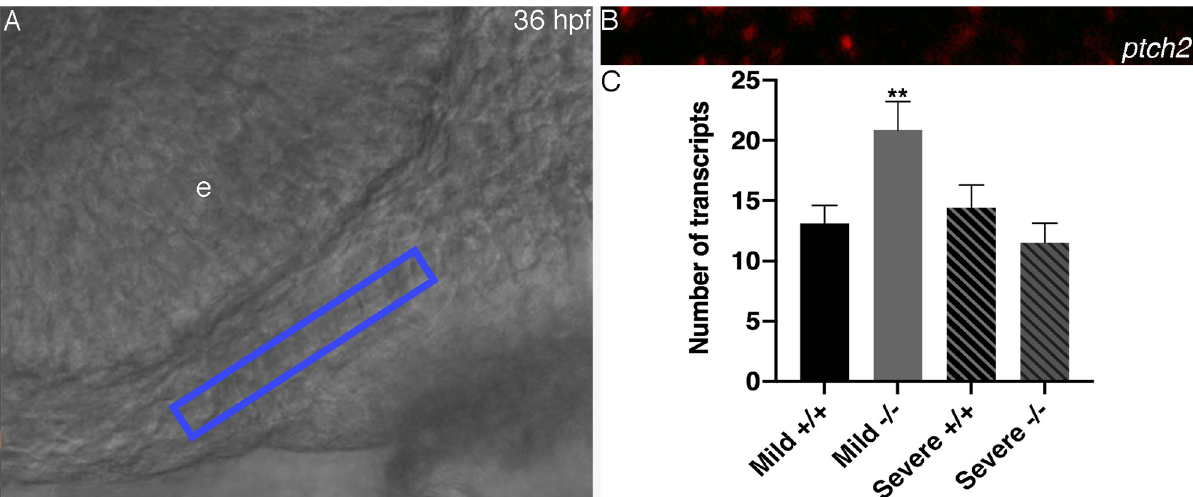
Fig 10. Upregulation of Shh signaling in mild mutants. (A) Lateral view of 36 hpf embryo, blue box indicates region of interest in the maxillary trabeculae precursors. (B) Confocal z slice of region of interest in (A). Red dots are labeled ptch2 transcripts. (C) Quantification for each group. Mild mutants have significantly elevated levels of ptch2 relative to the severe mutants (p = 0.0085) and the mild wild types (p = 0.0183). Mild wild type x = 13.11, S.E. = 1.506, n = 18; mild mutant x = 20.87, S.E. = 2.360, n = 15; severe wild type x = 14.40, S.E. = 1.904, n = 15; severe mutant x = 11.50, S.E. = 1.640, n =